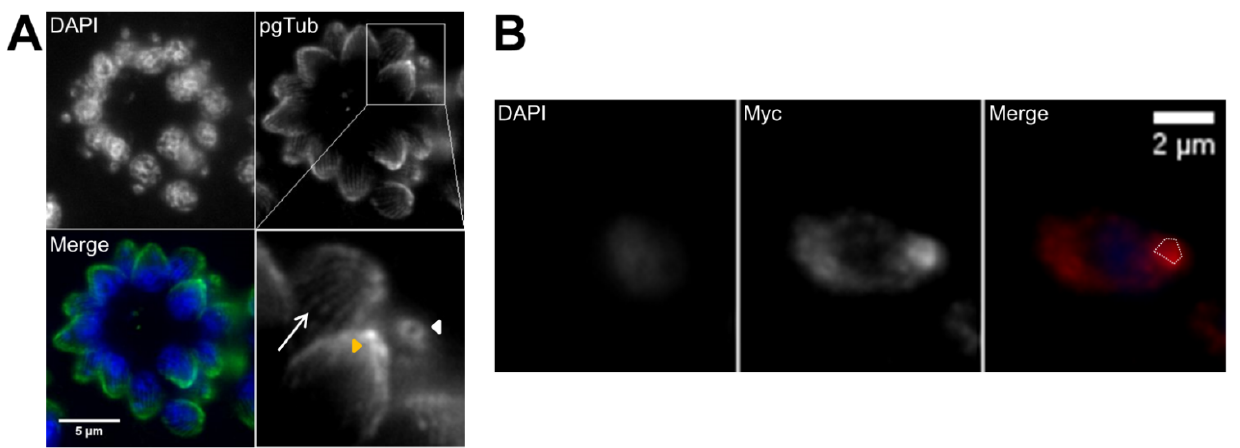
Figure 2. Tachyzoite apical cytoskeleton and basal complex. ( A ) Apical cytoskeleton. Immunofluorescence of intracellular tachyzoites where retracted conoids and subpellicular microtubules are visible. The tachyzoite apical structures are identified by polyglutamylated tubulin (pgTub), namely, the conoid and attached rings (white arrowhead in top view, yellow arrowhead in side view) and the subpellicular microtubules (arrow), visible in the detail at the bottom right of the panel. The scale bar represents 5 µm. ( B ) Basal complex. Immunofluorescence of intracellular tachyzoites stably expressing a MORN1-Myc recombinant protein coupled to the MORN1 promoter region. MORN1-Myc accumulates at the basal pole, forming the basal polar ring (highlighted by the white dotted line). The recombinant protein is stained with anti-Myc. The scale bar represents 2 µm. DNA is stained with DAPI. IMC—inner membrane complex; PM—plasma membrane; MTs—microtubules.